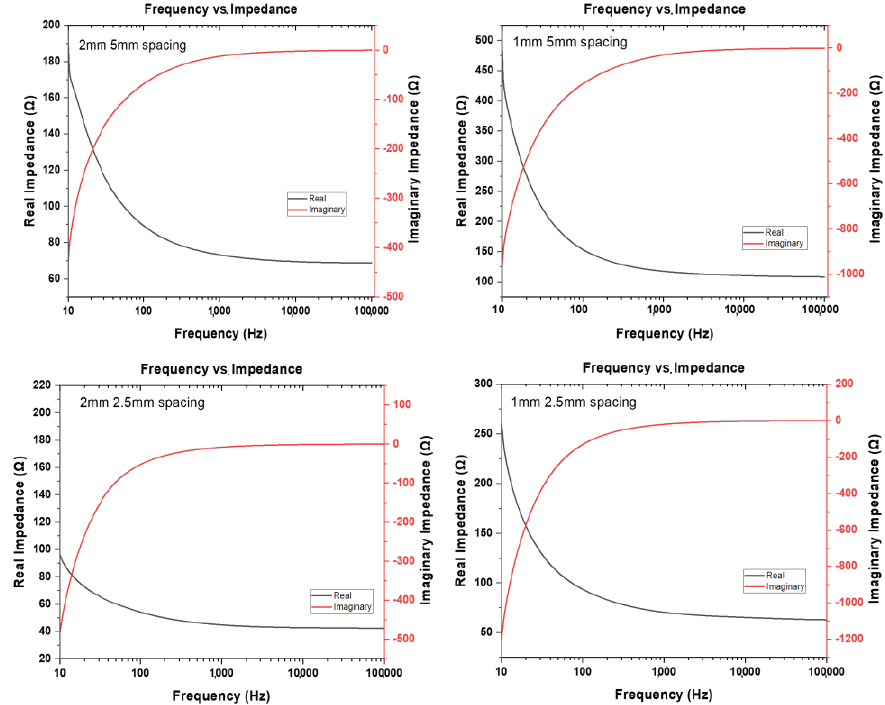
Figure 8. Full spectrum (Range from 1 Hz to 100 kHz) measurements for 1 mm and 2 mm pitch IDE device. (Showcased as metal patterned Cr/Au). Each device was recorded three times and a statistical average of the real and imaginary parts of the impedance are presented.